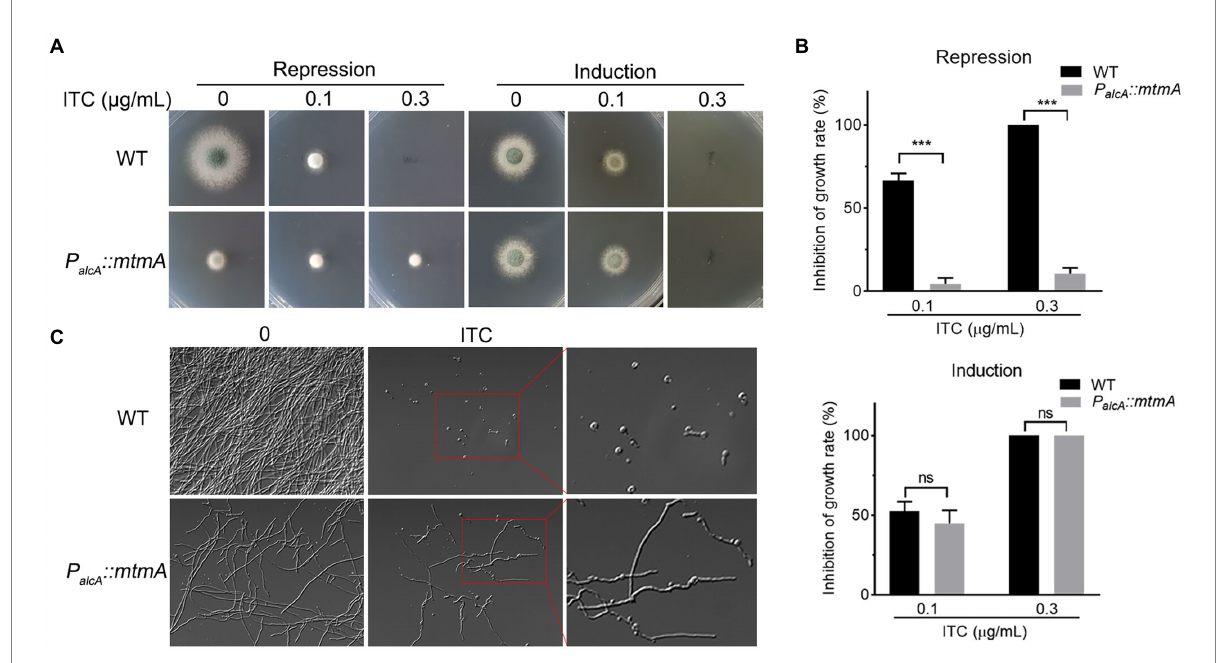
FIGURE 1 Repressed expression of MtmA causes itraconazole resistance. (A) Conidia of each indicated strain were inoculated on repression (MM + glucose) or induction (MM + glycerol) medium containing serial concentrations of itraconazole (ITC) for 2 days at 37 ° C. (B) Mycelium growth inhibition ratios of the indicated strains on YAG and MM plus glycerol with different concentrations of itraconazole (ITC). Data are presented as the means ± standard deviation (SD) of the results from three independent experiments. Statistical significance was determined by Student’s t test. ***, p < 0.001; ns, not significant. (C) Hyphal morphologies of the indicated strains grown on liquid MM + glucose in the presence or absence of 0.5 μ g/ml ITC for 24 h at 37 °